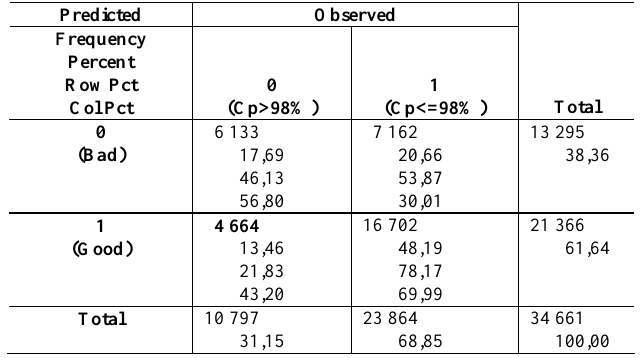
Table 2 Predicted probability split at